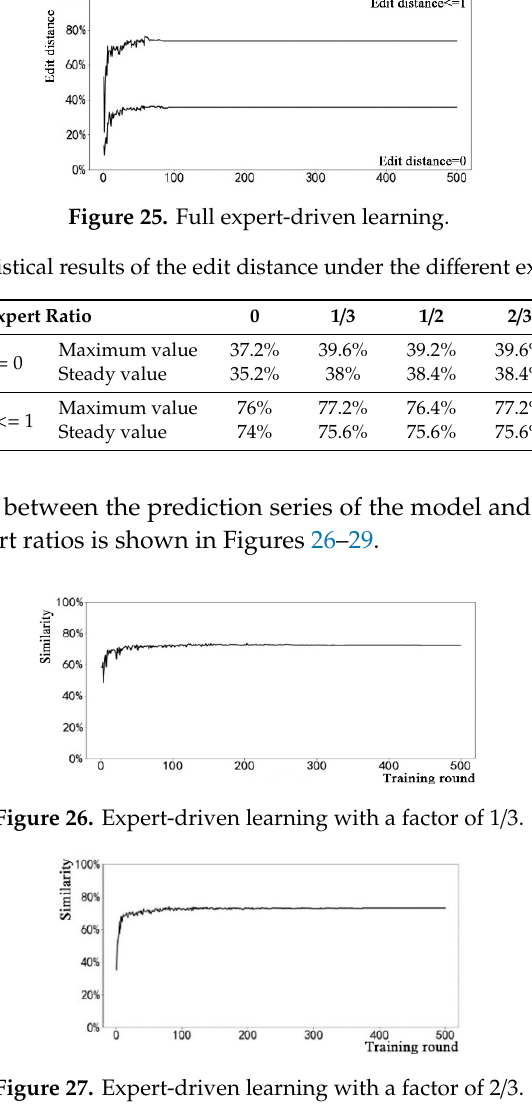
Figure 28. Expert-driven learning with a factor of ½. Figure 29. Full expert-driven learning. The statistics of series similarity under different expert ratios are shown in Table 5. Table 5. Statistical results of the series similarity. Expert Ratio